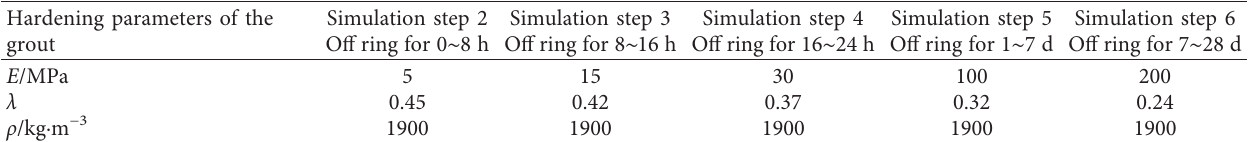
Table 10: Hardening parameters of the